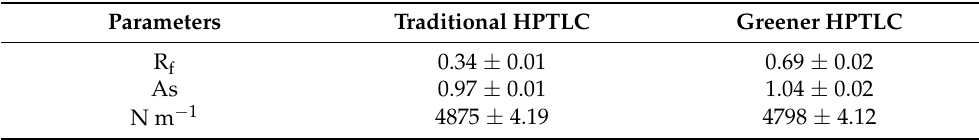
Table 2. System suitability parameters of traditional and greener HPTLC methods for VD3 estimation (mean ± SD; n = 3). Parameters Traditional